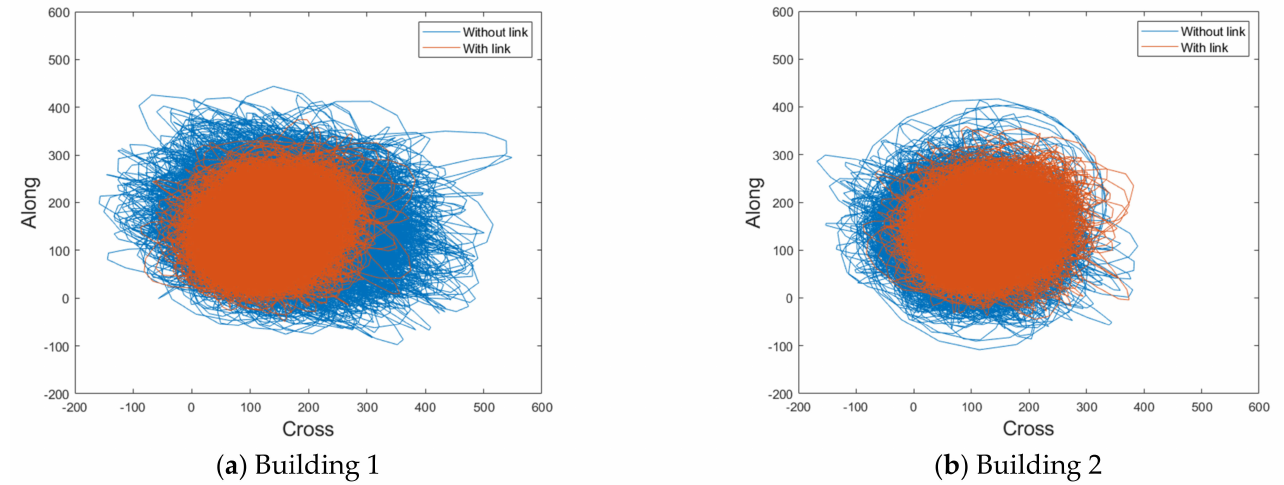
Figure 18. Trajectories for lateral displacement with a large gap distance (unit: